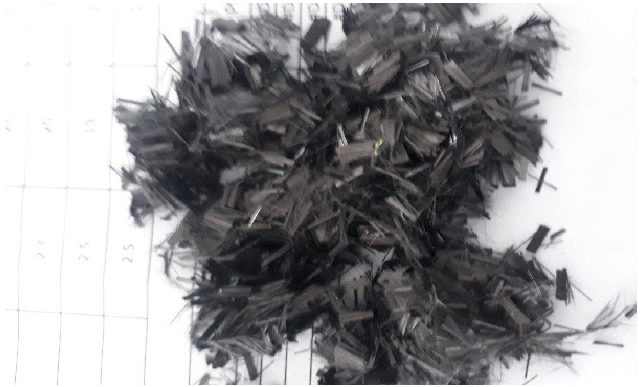
Figure 1. Carbon fiber used in this study.